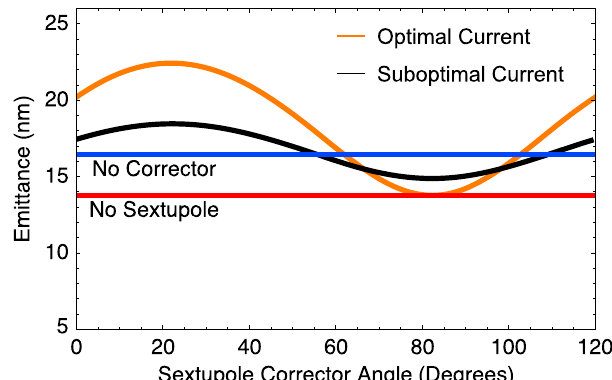
moment.FIG. 5. Simulated emittance at the sample location varying the angle of a sextupole corrector placed after the second solenoid. The red horizontal line is the emittance of the beamline with no sextupoles included. The blue horizontal line is the emittance of the beamline with a sextupole in the buncher and no corrector. The orange and black curves show the resulting emittance for a corrector current which exactly cancels the sextupole moment and is approximately one third of the needed current,